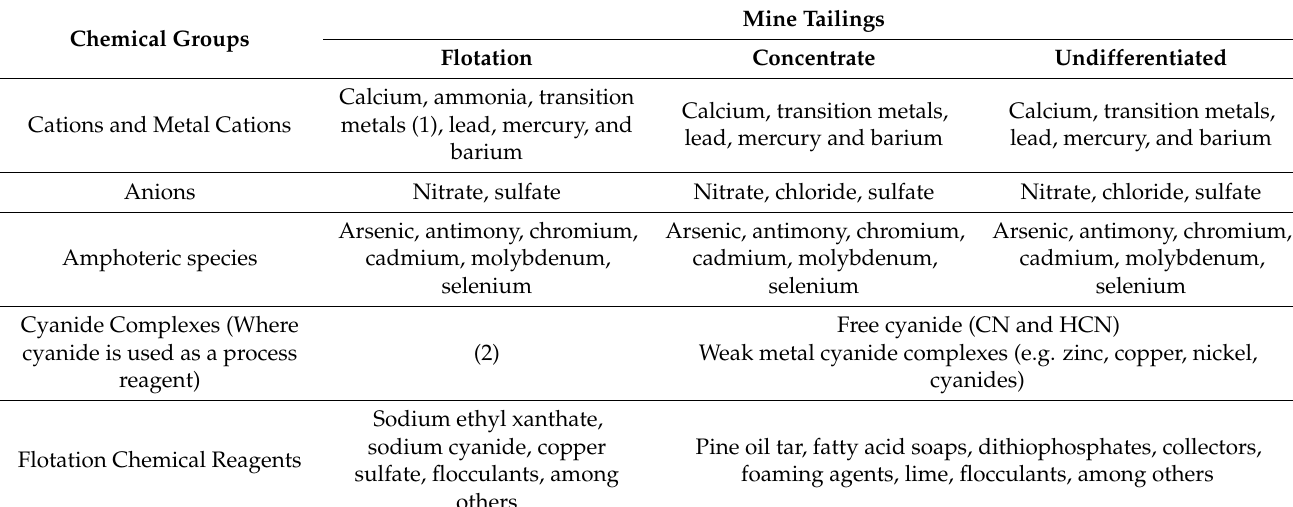
Table 1. Potentially Mobile Chemical Species in Tailings Slurries